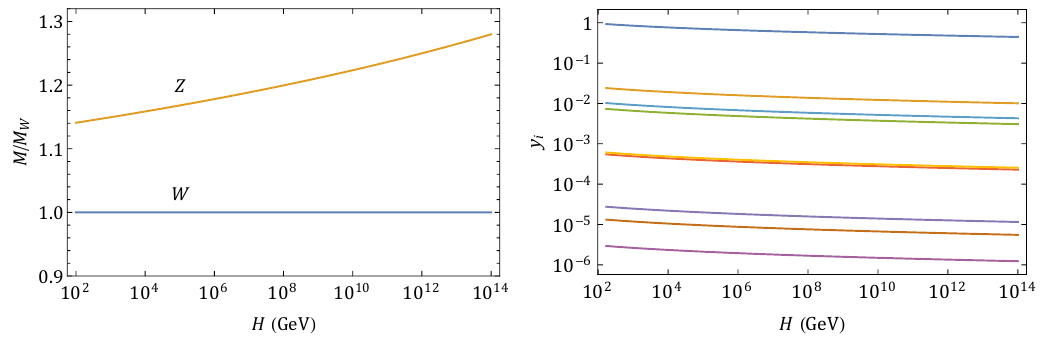
Figure 4 . The gauge boson masses (left panel) and Yukawa couplings (right panel) as functions of Hubble scale H , using 2-loop SM renormalization group running. On left panel, the masses of Z and W (from top to bottom) are normalized by the mass of W ; on right panel, various curves from top to bottom correspond to Yukawa couplings of t; b; (cid:28); c; (cid:22); s; d; u; e ,